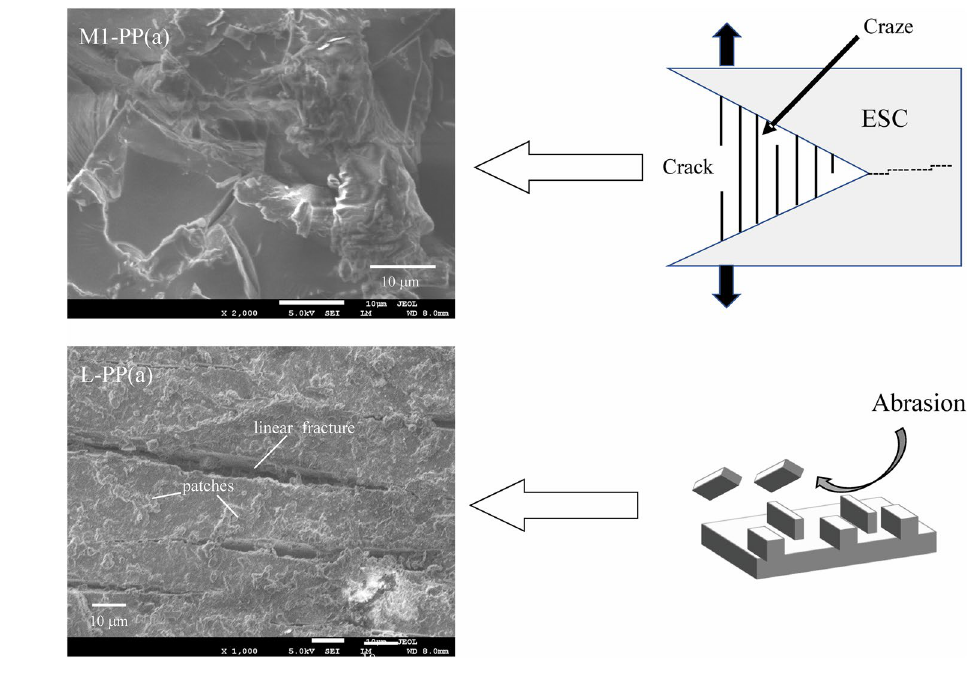
Fig. 3 SEM micrographs and plausible mechanisms to